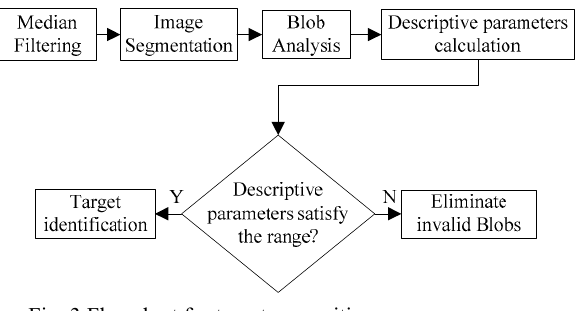
Fig. 3 Flowchart for target recognition.